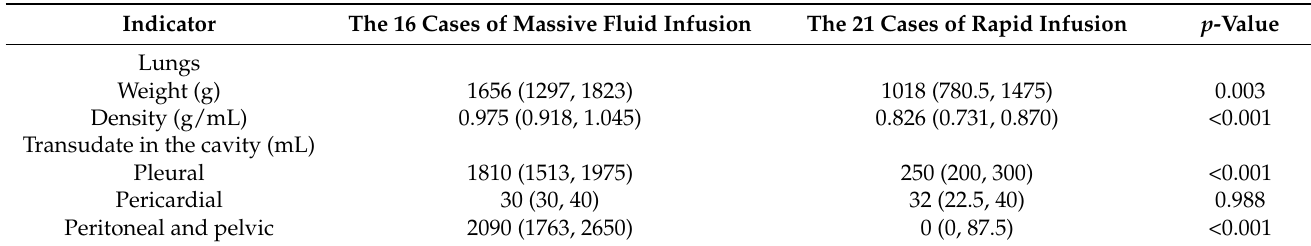
Figure 2. The pathologic changes of macroscopic and microscopic examination in the 16 cases of massive fluid infusion ( a – d ) and the 21 cases of rapid infusion ( e ). Notes: ( a ) a widespread swelling of the systemic skin; ( b ) a pale-yellow liquid overflowed from the subcutaneous when making an incision in the epidermis; ( c ) a diffused frothy-like edema of diaphragm tissues; ( d ) hypotonic pulmonary edema: formation of hyaline membrane and a blank and lightly staining of alveolar spaces in HE, ×200; ( e ) diffused infiltration of monocytes and lymphocytes in the myocardial interstitial in HE, ×400. Table 6. Lung weight and density and transudate in the cavities.